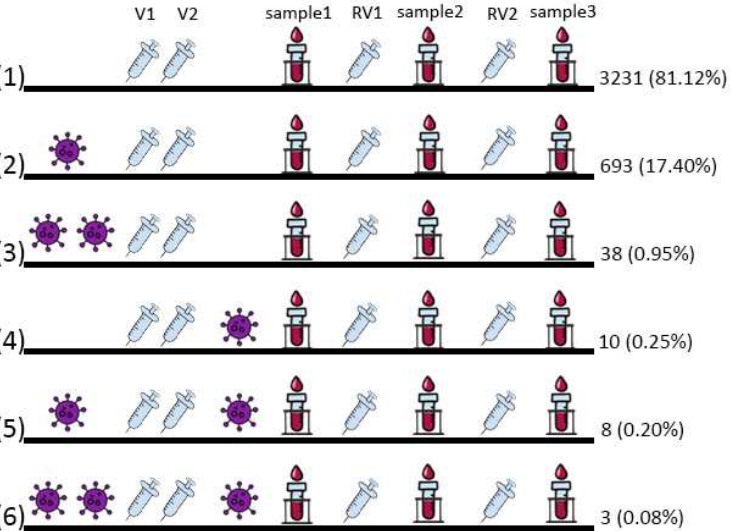
Figure 1. General distribution of vaccinations according to possible variants of the combination of COVID-19 contraction and vaccination in the first analysis: (1) did not get COVID-19; (2) got sick once before vaccination; (3) got sick twice before vaccination; (4) got sick once after vaccination; (5) got sick twice: first time before vaccination, the second time after; and (6) got sick three times: twice before vaccination and once after. The figure conventionally indicates the time of the disease, the time of vaccination (V1 and V2) and revaccination (RV1 and RV2), and the time of taking the analysis (sample 1, sample 2, and sample 3). The number of people and the proportion of the entire sample under study are given.